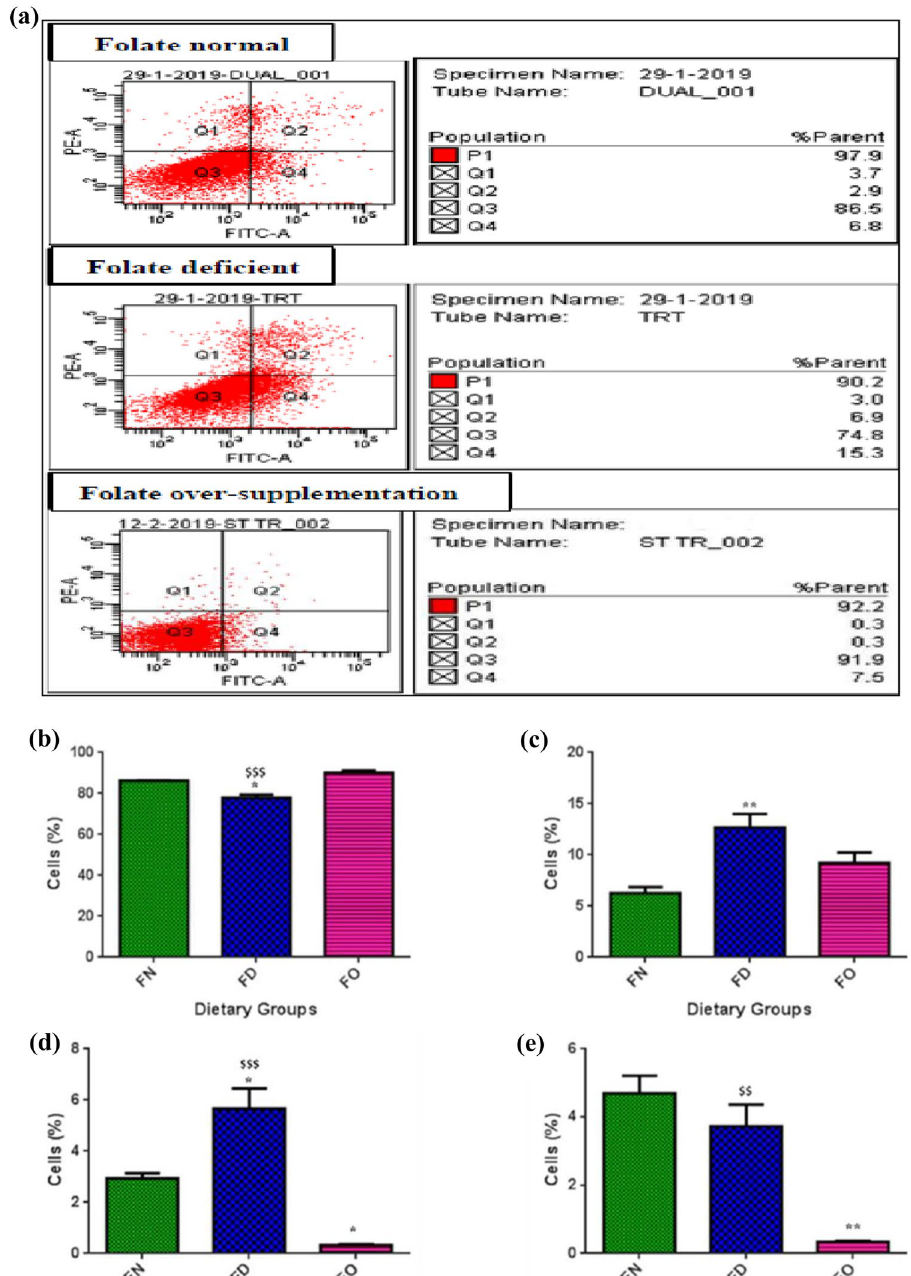
Figure 3. Effect of folic acid deficiency and oversupplementation in HepG2 cells on ( a ) PI-Annexin assay by flow cytometry. ( b ) Cell viability ( c ) Early apoptosis ( d ) Late apoptosis ( e ) Necrotic cells. * P < 0.05, ** P < 0.01 versus FN, $$ P < 0.01, $$$ P < 0.001 versus FO; FN-Folic acid normal, FD-Folic acid deficient, FO-Folic acid